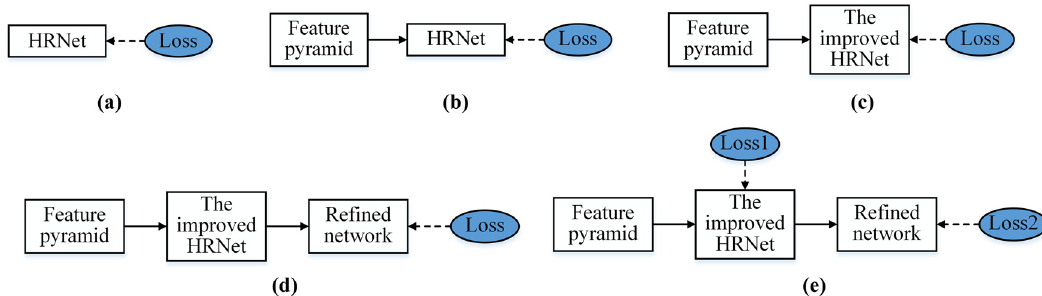
Figure 7: The network structure of the ablation